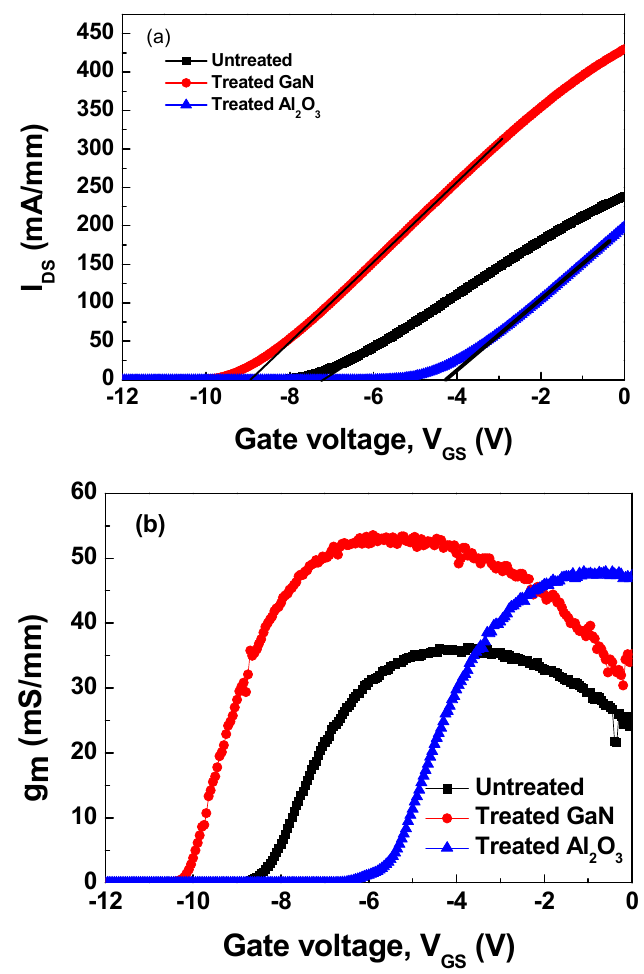
Figure 4. ( a ) I DS –V GS and ( b ) and g m –V GS transfer characteristics of the MOS-HEMT devices with and without the corona-discharge plasma treatment measured at V DS = 10 V.